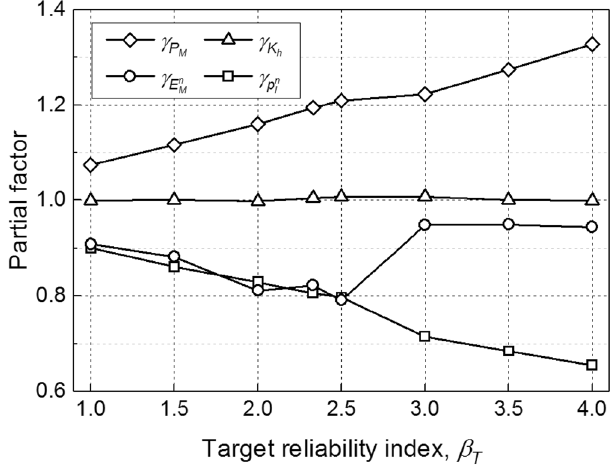
Figure 7. Calibrated partial factors for various target reliability